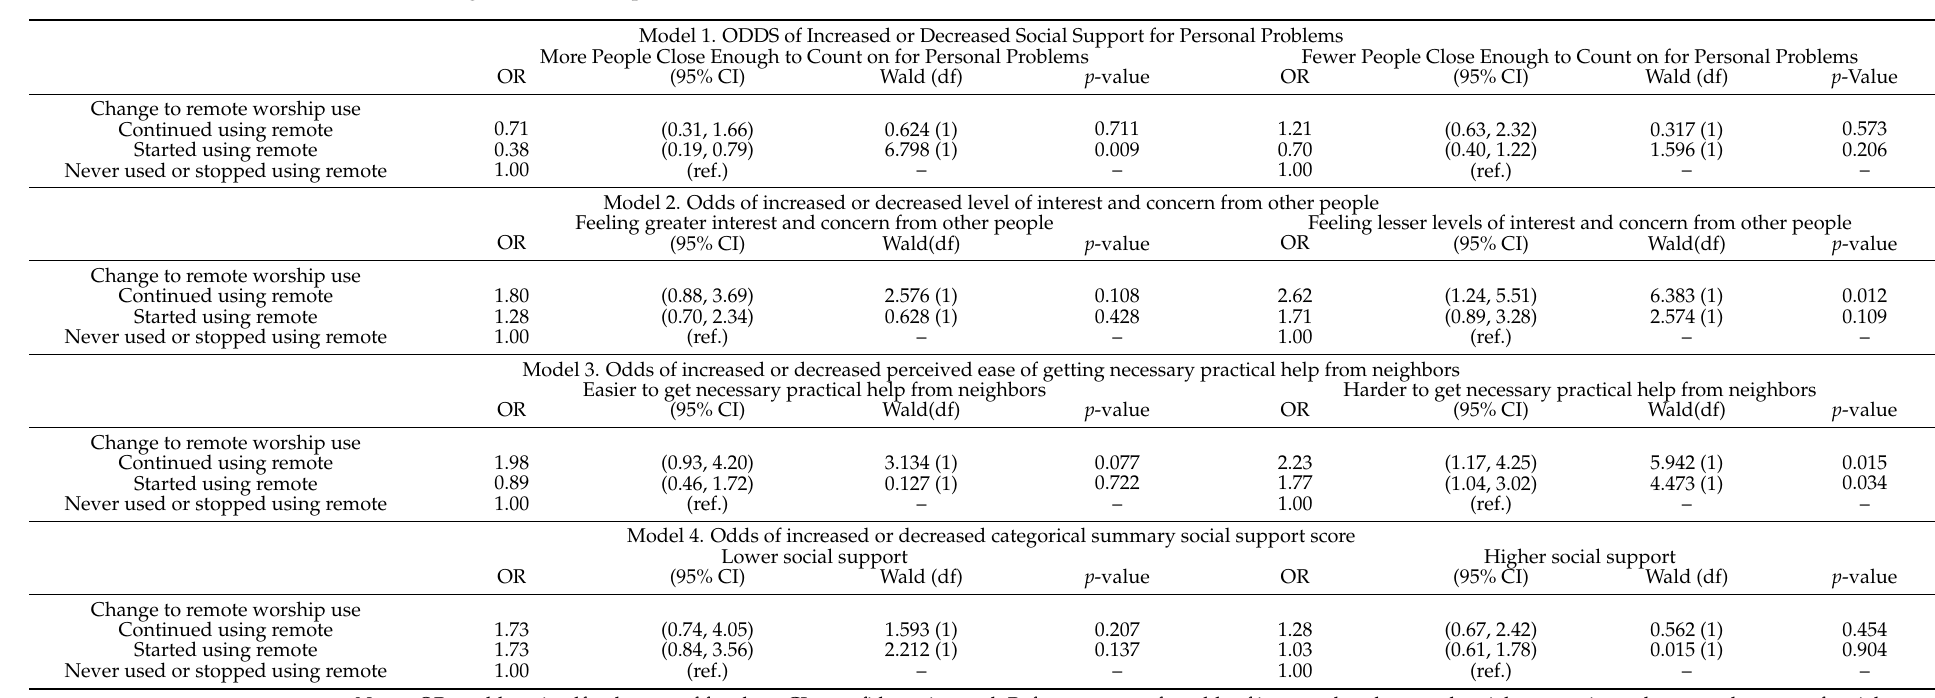
Table 3. Unadjusted multinomial logistic regression models for odds of increase or decrease for three types of social support and categorical summary social support score during the COVID-19 pandemic ( n =